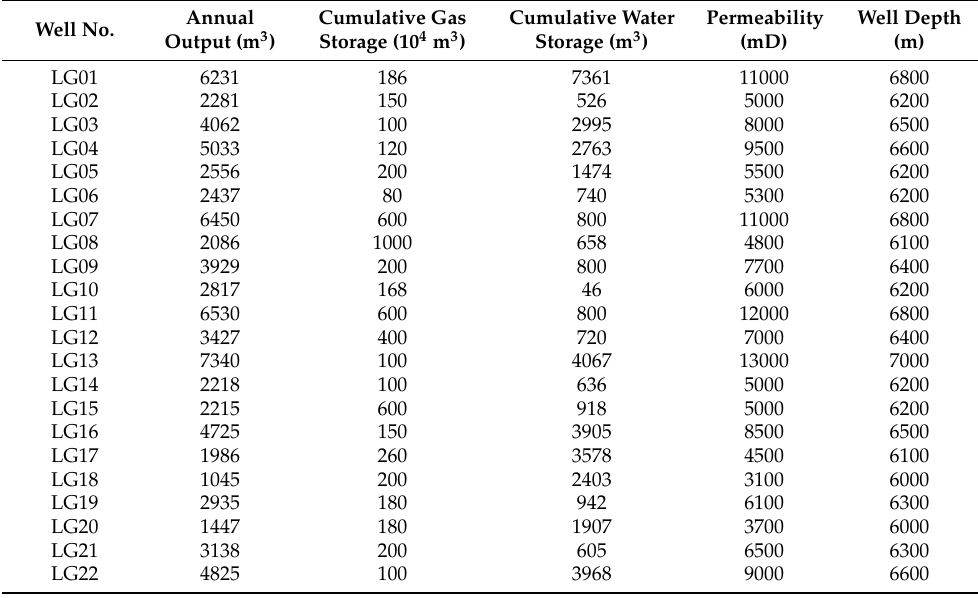
Table 1. Raw data of the four controlling factors to N 2 huff-n-puff. Well